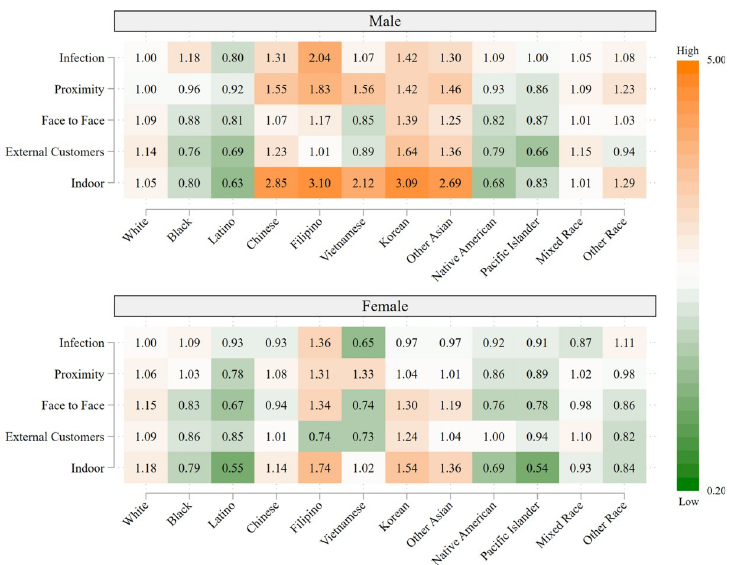
Fig 1. Representation of frontline workers in high-risk occupations relative to representation as frontline workers, by race/ethnicity and sex. Data are from the 2018 American Community Survey (ACS). Occupations are considered to be high-risk if the average value for the risk factor in the O � NET data falls in the highest quartile of the occupations in the analysis.